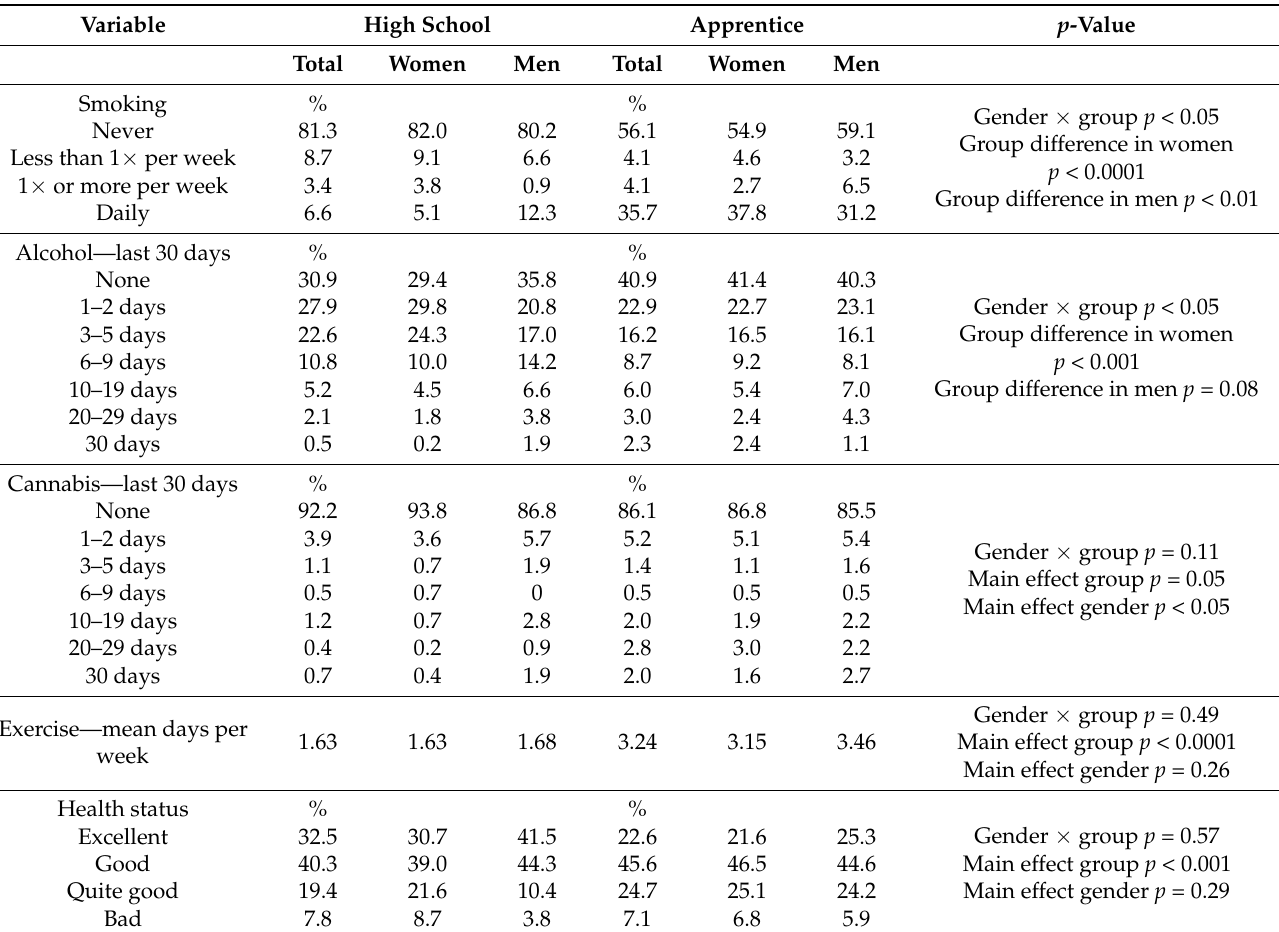
Table 1. Percentage of school students and apprentices who engage in each health